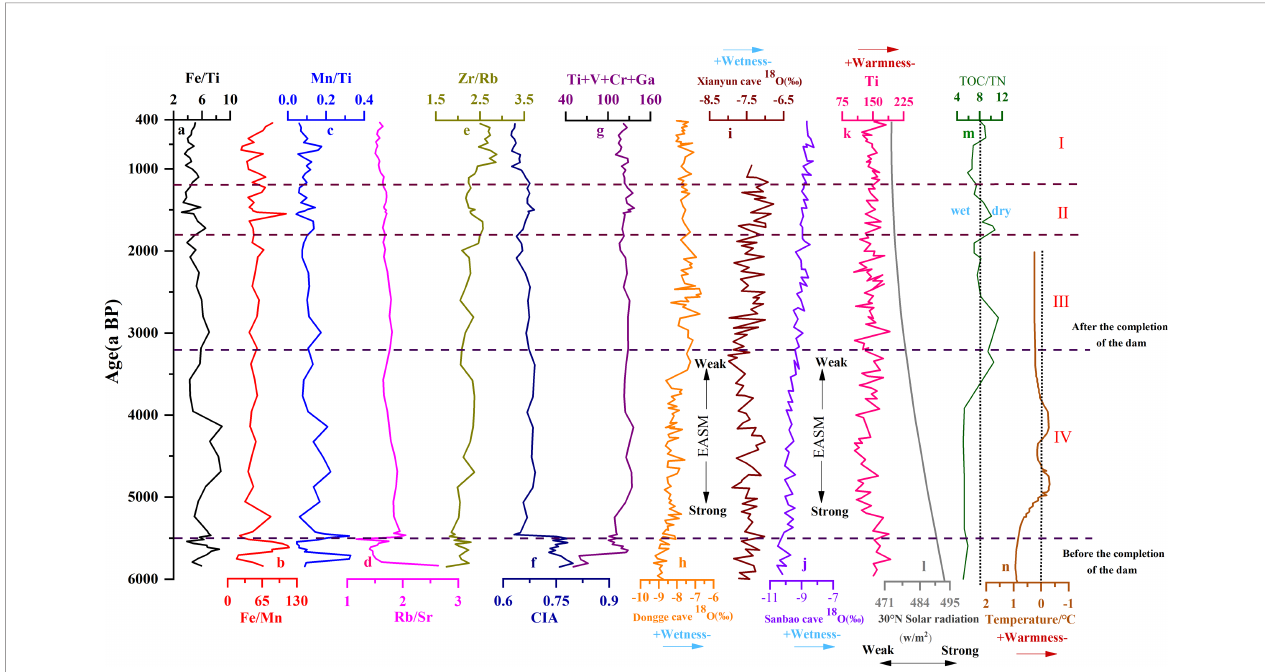
FIGURE 5 | Comparison of EASM records from GGL section (A – G) and other monsoon regions records. (H) Stalagmite 18 O record from the Dongge Cave in China (Dykoski et al., 2005); (I) Stalagmite 18 O record from the Xianyun Cave in China (Che et al., 2018); (J) Stalagmite 18 O record from the Sanbao Cave in China (Dong et al., 2013); (K) Elemental intensity of Ti in Huguangyan Maar Lake (Wu et al., 2011); (L) 30°N June Insolation (Berger and Loutre, 1991); (M) Ratio of total organic carbon to total nitrogen (TOC/TN) (Yang et al., 2011); (N) Pollen records of Core CM97 (Yi et al.,